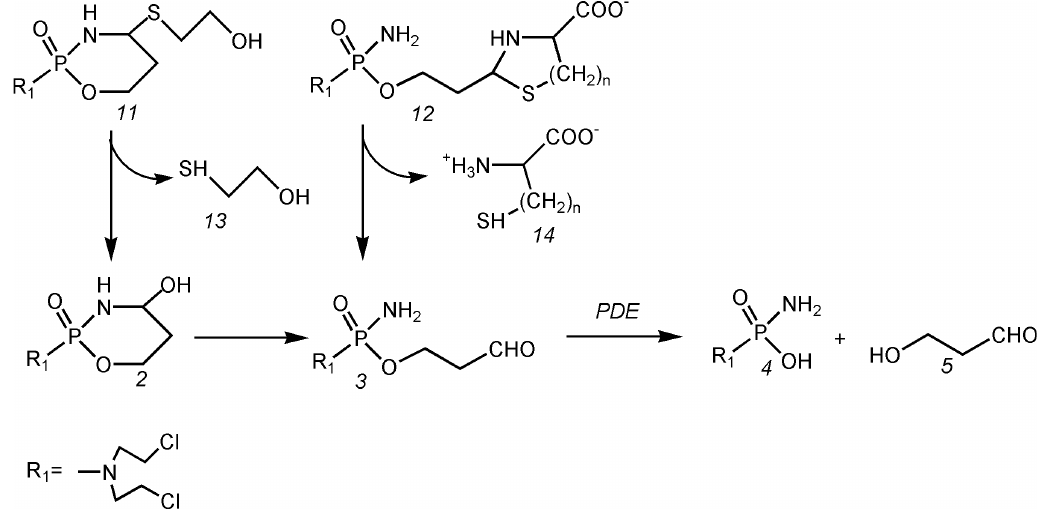
Table 3. Acute toxicity of 4-(S-ethanol)-cyclophosphamide ( 11 Figure 4), aldophosphamide thiazolidine ( 12, n = 1 Figure 4) and aldophosphamide perhydrothiazine ( 12 , n = 2 Figure 4) in female NMRI mice, single intraperitoneal injection, observation period 30 days.